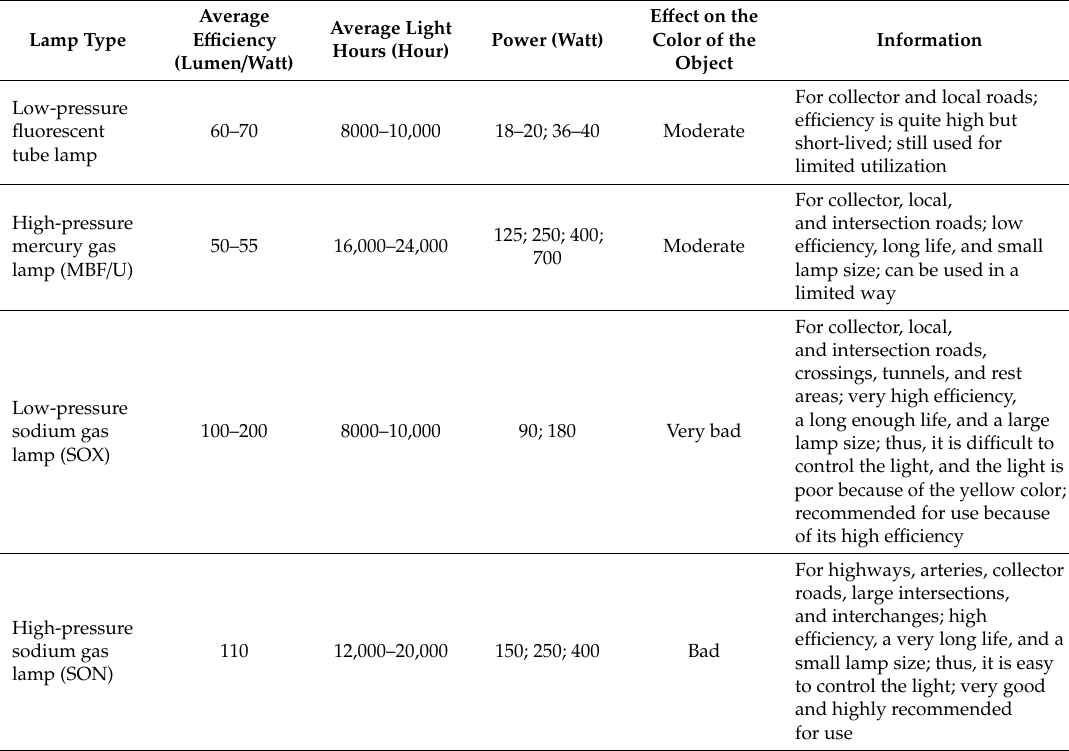
Table 1. Public street lighting lamp type characteristics based on